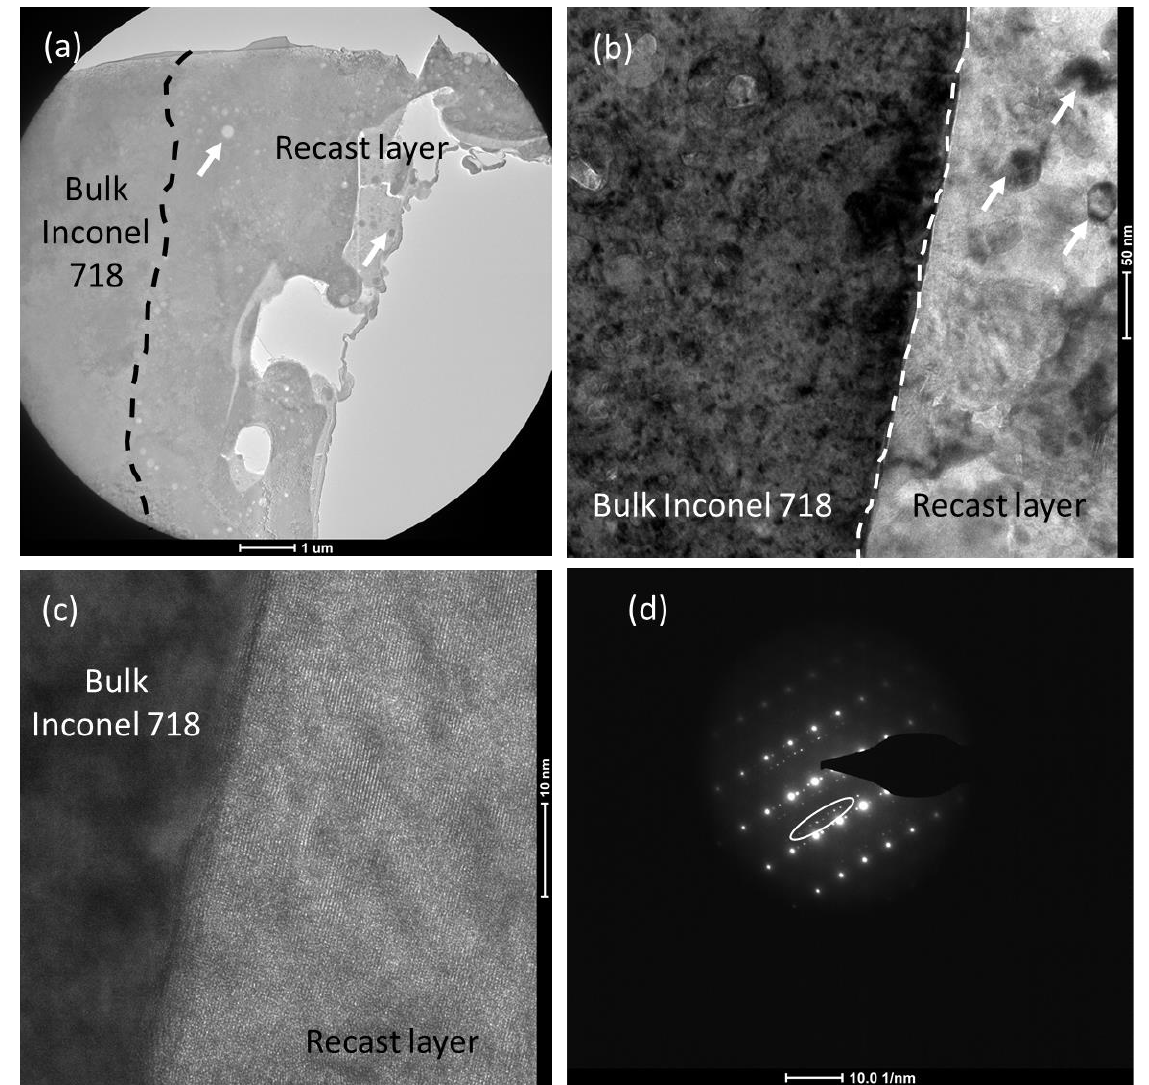
Figure 4. Representative transmission electron microscopy (TEM) images of the recast layer: ( a ) Brightfield (BF)-TEM image together with bulk material, ( b ) the interface of the recast layer with the bulk material, ( c ) high-resolution (HR) TEM image of the interface, and ( d ) corresponding selected area electron diffraction (SAED) pattern.